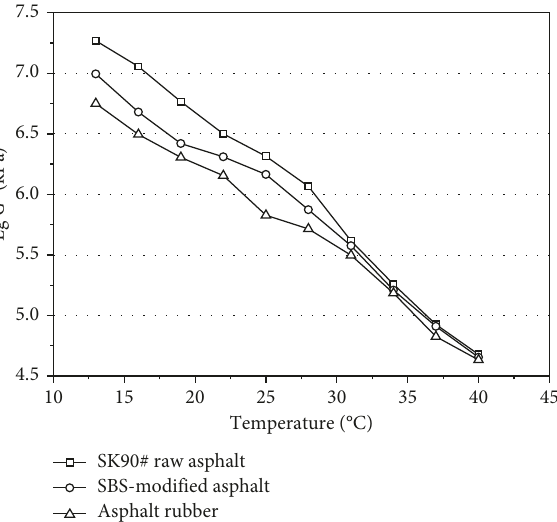
Figure 6: Phase angles of asphalt at different temperatures.